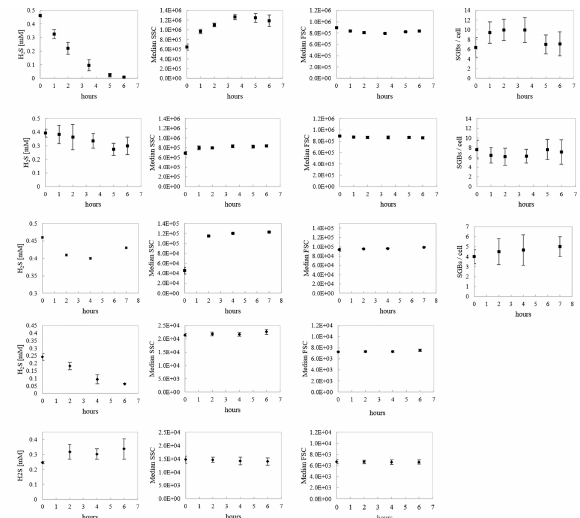
Fig 2. Flow cytometrydynamic response to sulfide oxidation in anoxygenic photosynthetic sulfur bacteria. H 2 S concentration [mM], medianSSC, median FSC and SGBs cell -1 for (A) PSB C . okenii under light incubation, (B) PSB C . okenii under dark incubation,(C) PSB Candidatus “T. syntrophicum” strain Cad16 T under light incubation,(D) GSB C . phaeobacteroides . under light incubation, (E) GSB C . phaeobacteroides under dark incubation. Starting concentration was 0.45 mM for PSB and 0.25 mM for GSB. Error bars represent standarddeviation(N = 3). If no error bars are shown, SD was smaller than the symbols used.